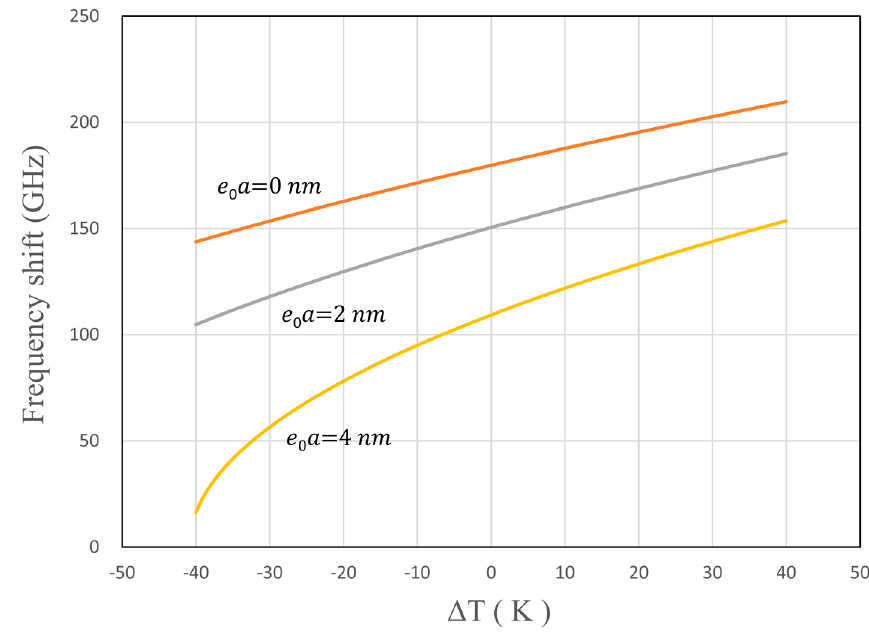
Figure 3. Variation of the vibration frequency shift with the temperature difference for different nonlocal parameters ( m = 100 zg, ξ = η = 0.5).